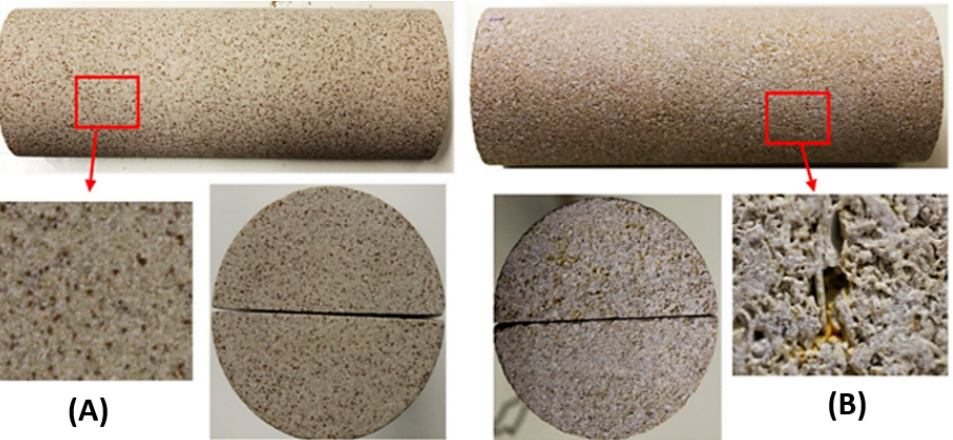
Figure 5. Images of ( A ) sandstone rock sample with relatively homogeneous matrix and ( B ) carbonate rock sample with heterogeneous matrix and vuggy porous media (Reprinted from Telmadarreie and Trivedi, 2018